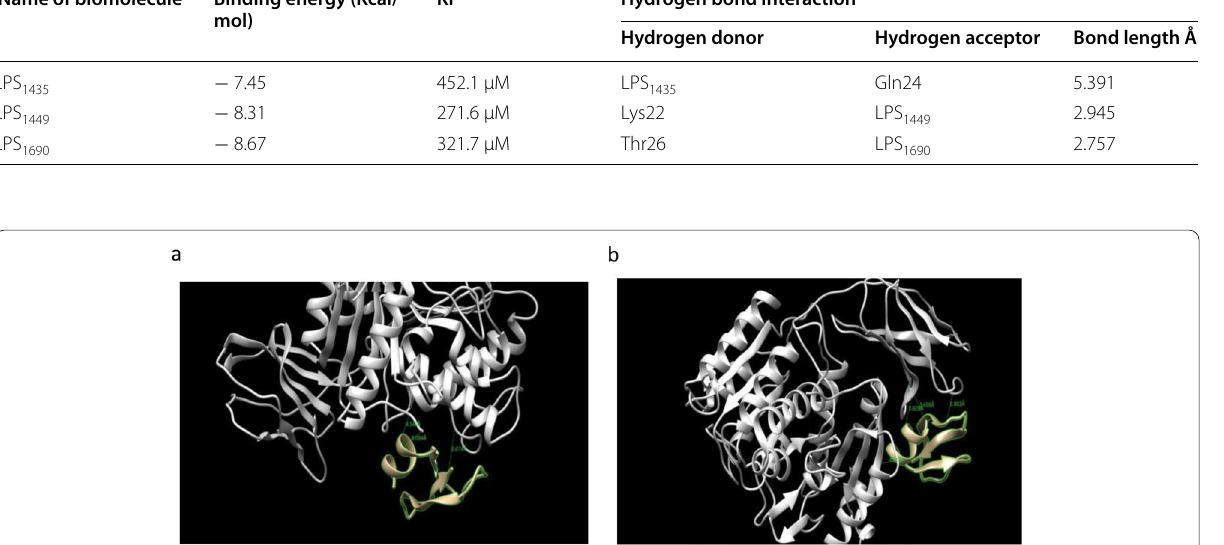
Fig. 8 Docking of β-defensin 1 against gingipains a Kgp and b RgpB of P.